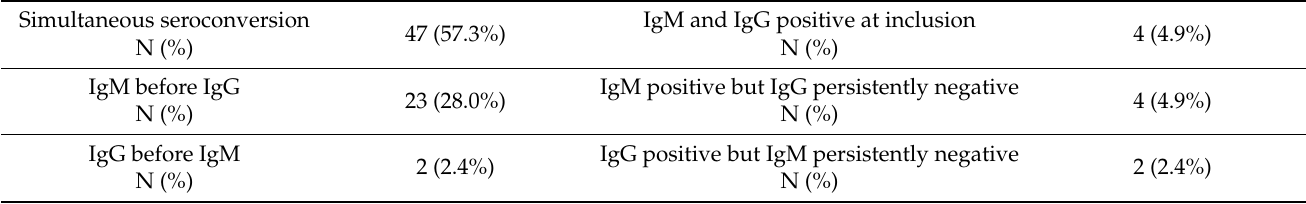
Table 4. The order in which IgM and IgG antibodies